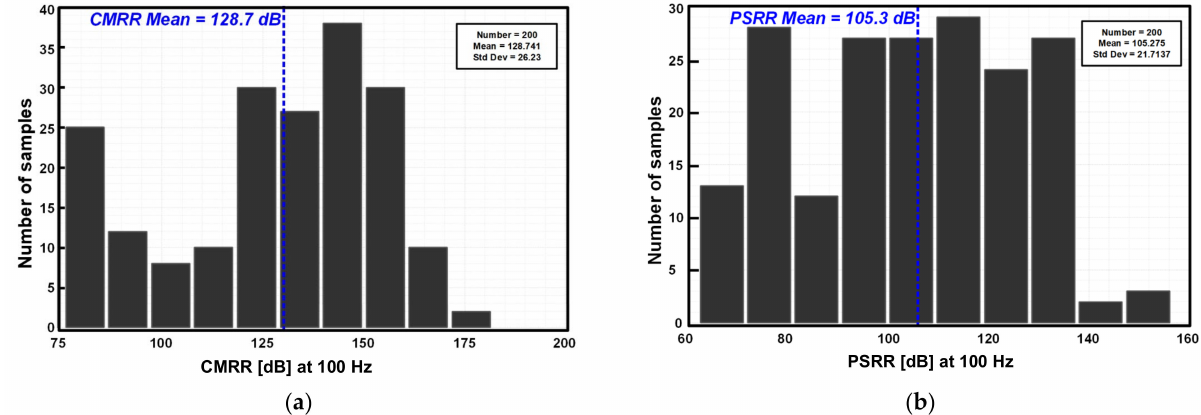
Figure 11. Monte Carlo simulation results of the ( a ) CMRR and ( b ) PSRR.